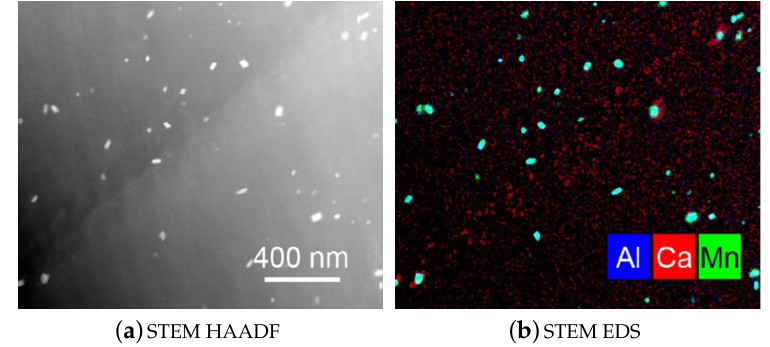
Figure 17. Micrographs made by scanning transmission electron microscope (STEM) high-angle annular dark-field (HAADF) ( a ) and corresponding STEM energy dispersive X-ray spectroscopy (EDS)( b ) of Al- and Mn- containing dispersoids (blue and green, respectively) in an extruded AXM100 alloy in T6 state. Ca-containing precipitates(shown in red) are visible as well [99]. Reproduced with permission from